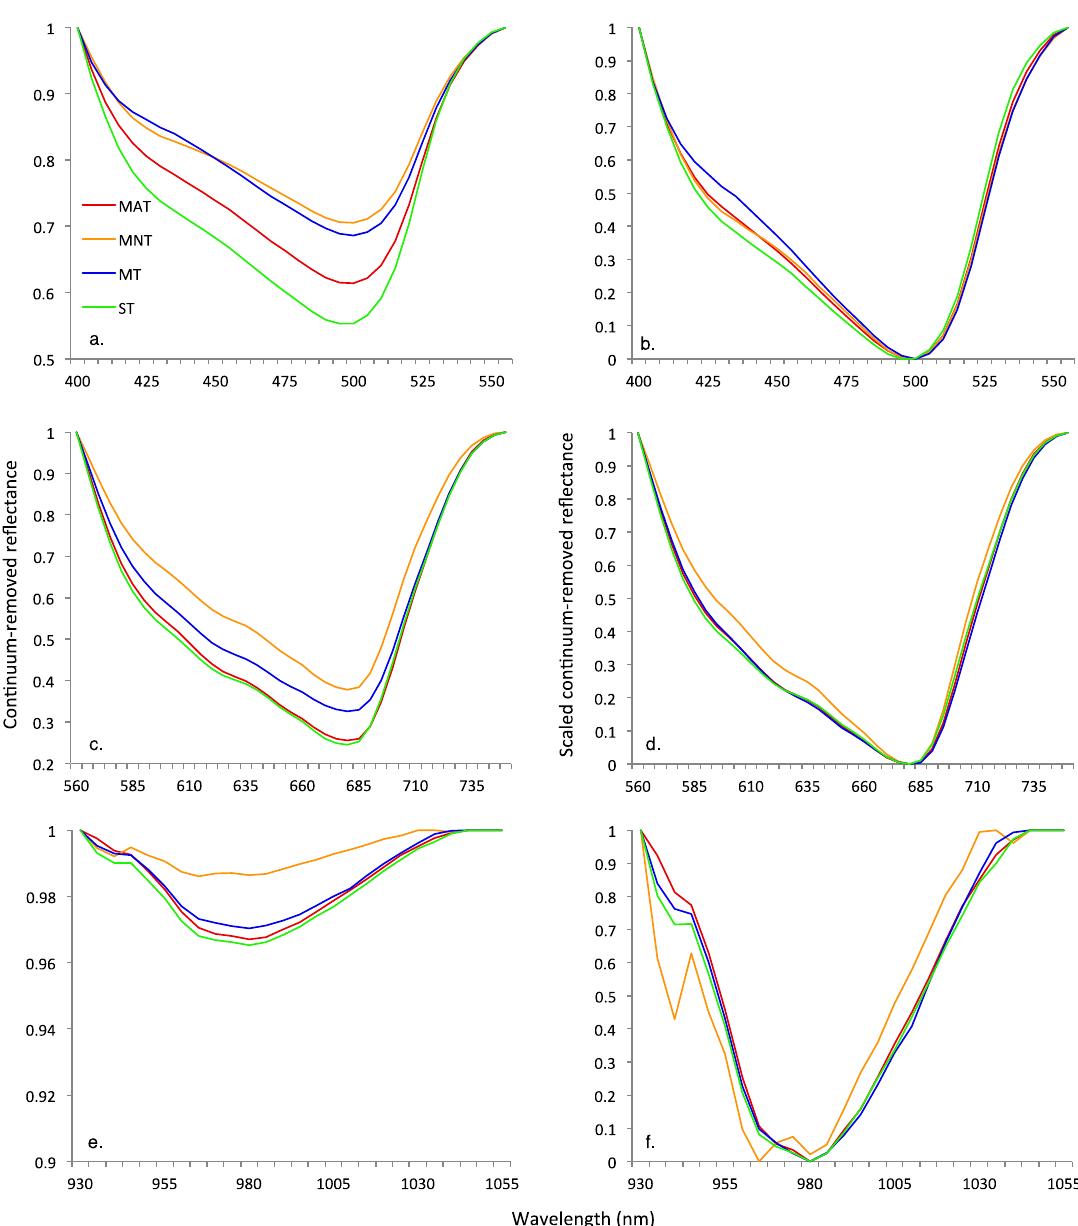
Figure 7. Average continuum-removed and scaled continuum-removed reflectance spectra at Ivotuk, Alaska for the blue ( a , b ), red ( c , d ), and water ( e , f ) absorption features during peak growing season.